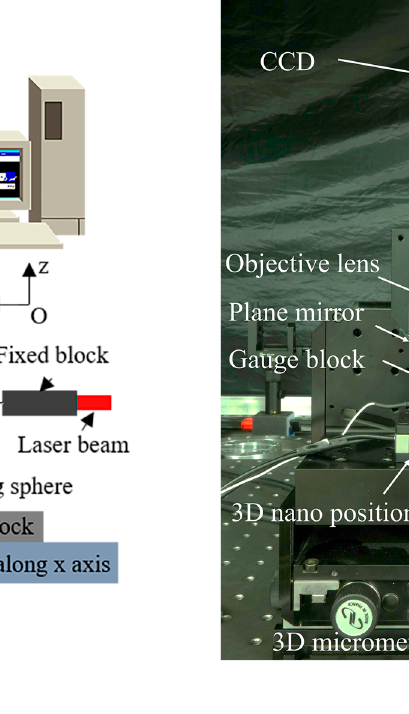
Figure 7. Experimental setup of the ACF probing system: ( a ) experimental schematic diagram of the probing system; and ( b ) experimental setup of the ACF probing